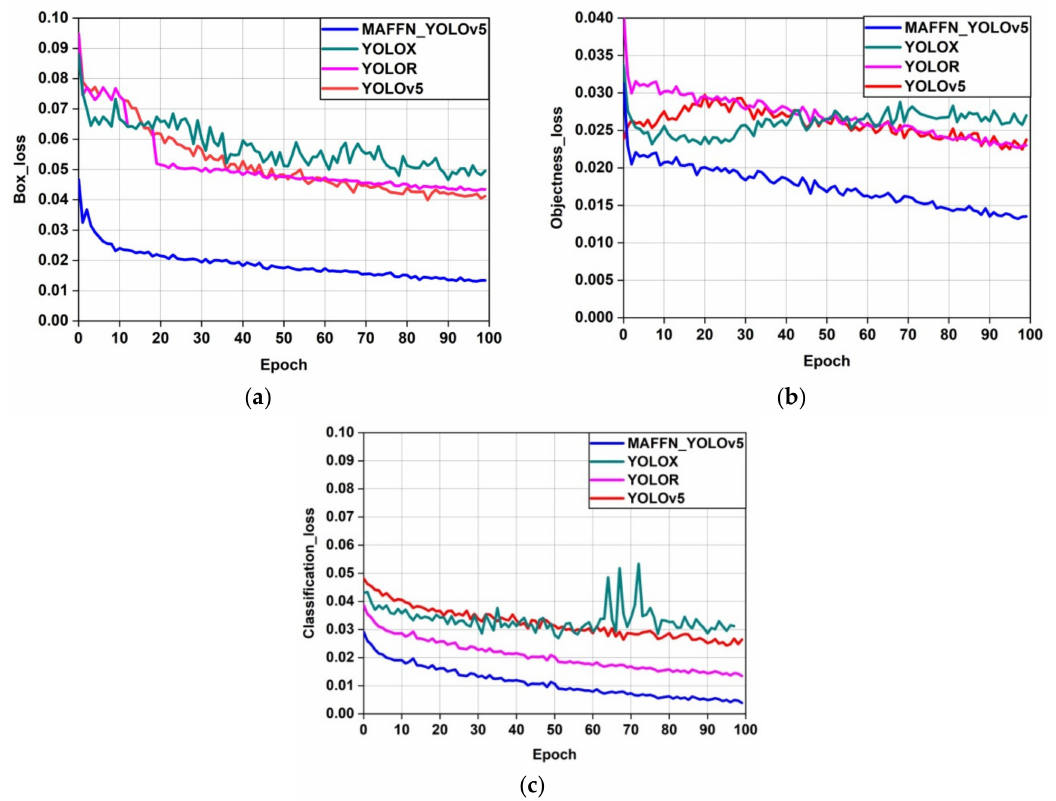
Figure 19. Comparison of box_loss ( a ), objectness_loss ( b ), and classification_loss ( c ) of the proposed MAFFN_YOLOv5, YOLOR, YOLOX, and